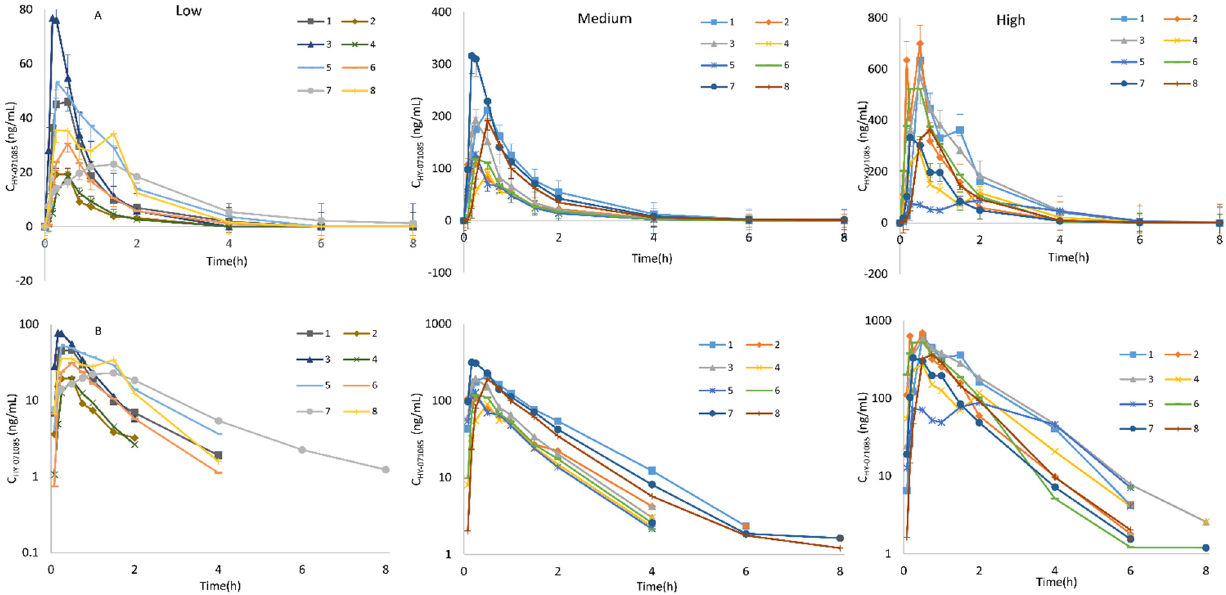
Figure 7. Mean plasma concentration–time curve of HY-071085 after the single-dose intragastric administration of HY-071085 at low (1.25 mg/kg), medium (2.5 mg/kg) and high (5 mg/kg) doses in beagle dogs. ( A ) Constant coordinates; ( B ) semilogarithmic coordinates. Table 2. Pharmacokinetic parameters of HY-071085 after single-dose intravenous and intragastric administration, and repeated-dose intragastric administration in beagle dogs (mean ±